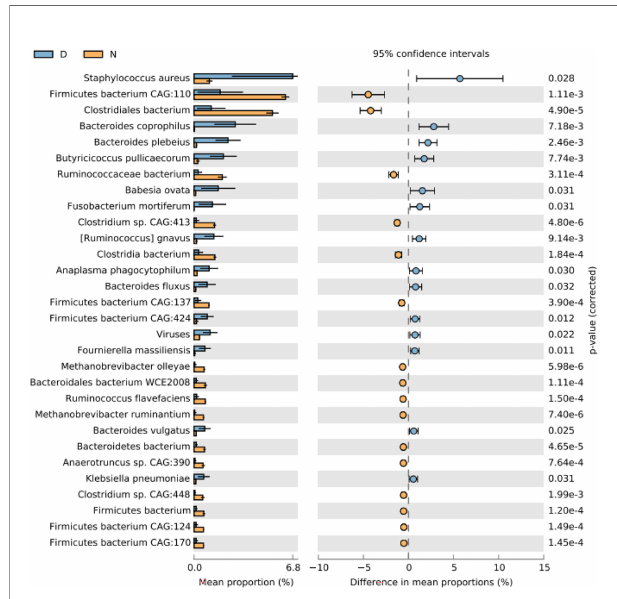
FIGURE 3 | Comparing intestinal microbiota difference between different yaks at species level. D, diarrheal group samples; N, normal group